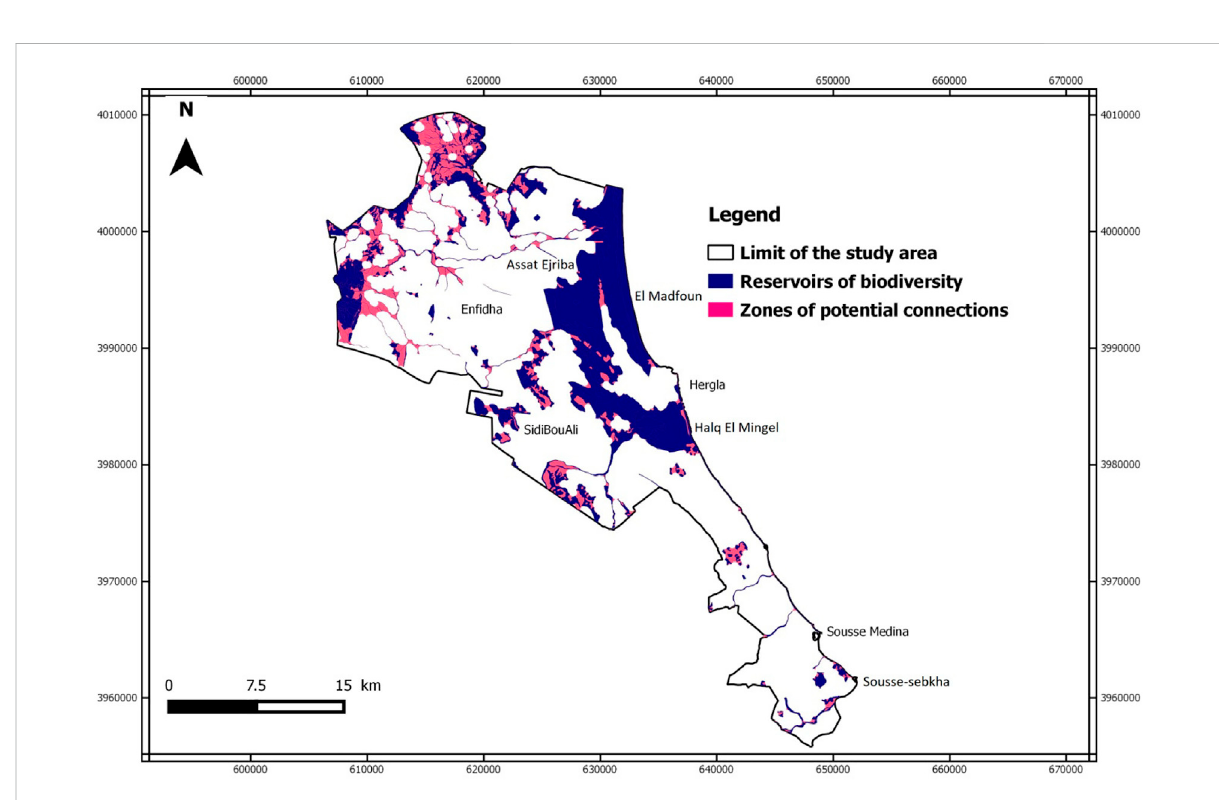
FIGURE 11 Potential connections of the wetland habitat